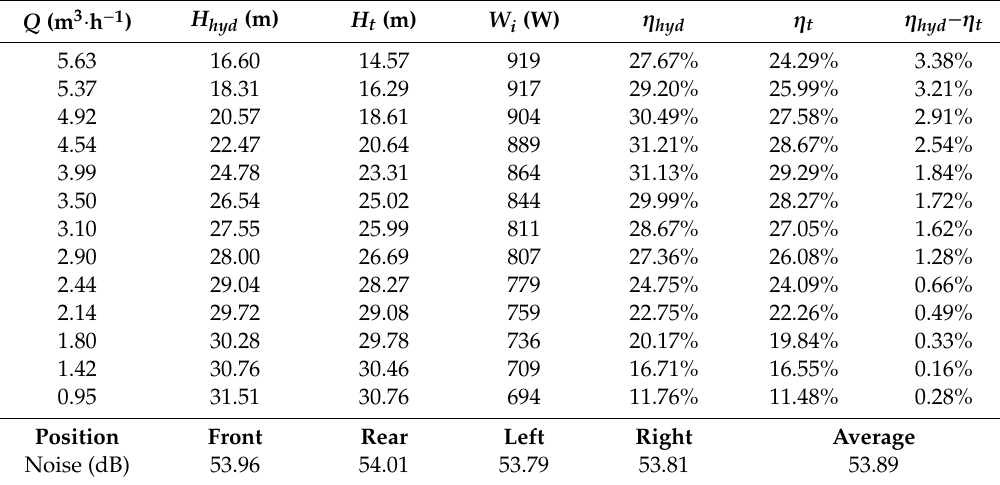
Table 3. Experimental results of high - speed pump at 7500 rpm.